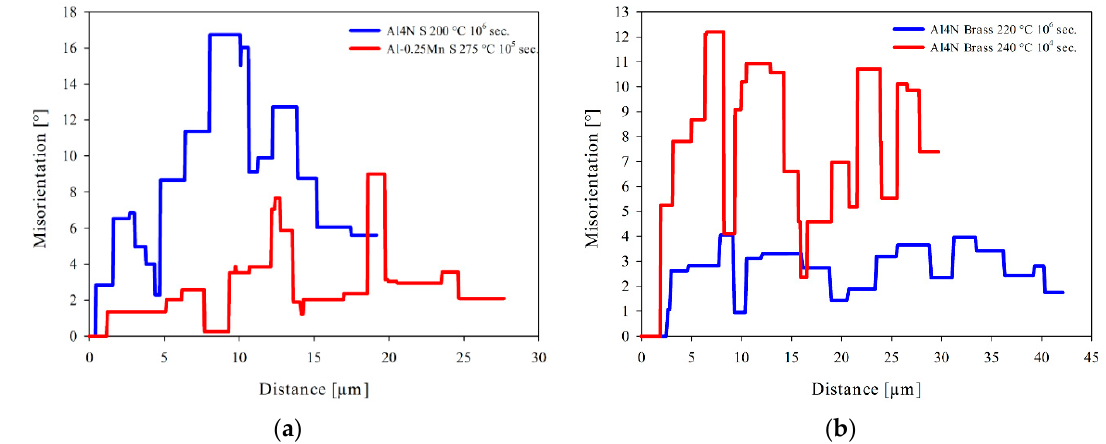
Figure 11. Characteristic orientation profiles in subgrain structures with S ( a ) and Brass ( b ) orientations resulting in different evolution of subgrain misorientations during coarsening.